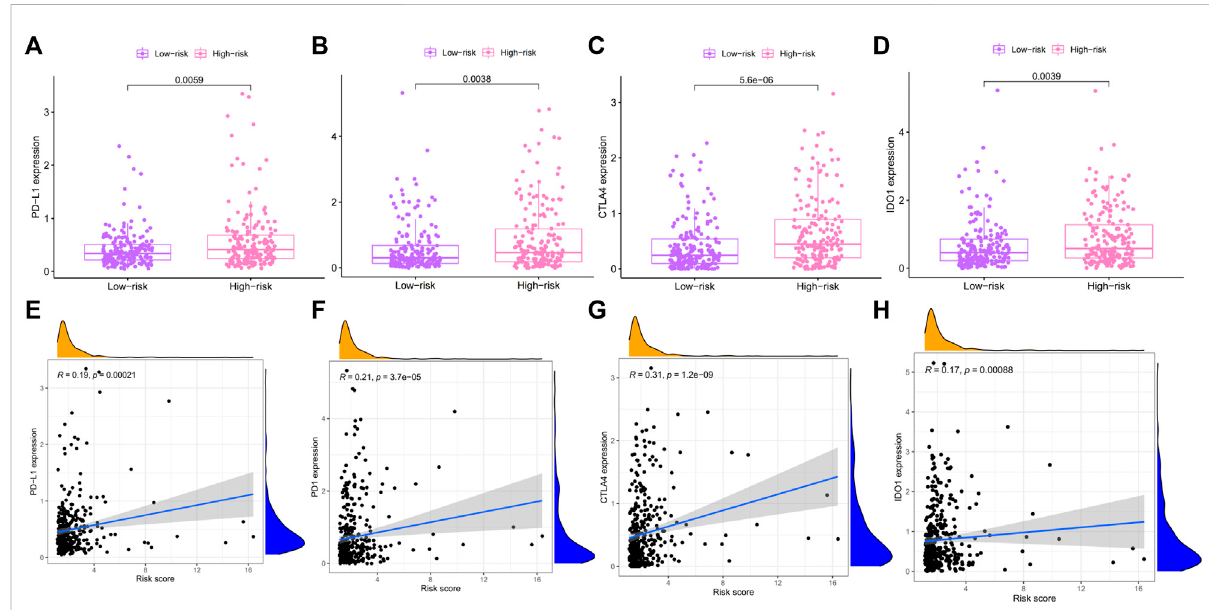
FIGURE 10 Association betweenriskscoreand immunecheckpoint. (A – D) ThedifferentialexpressionofPD-L1, PD-1,CTLA4,andIOD-1inhigh-andlow- risk groups. (E – H) Correlation between PD-L1, PD-1, CTLA4, and IOD-1 and risk score were evaluated by Pearson correlation analysis. PD-1: Programmed Death receptor 1; PD-L1: Programmed Death Ligand 1; CTLA4: Cytotoxic T Lymphocyte Antigen 4; IOD-1: